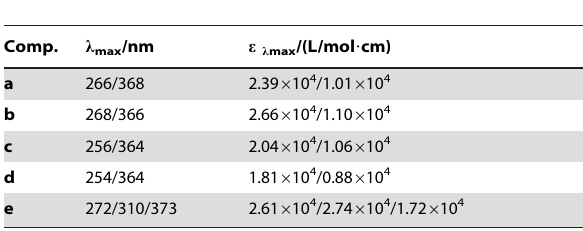
Table 6. Electronic absorption spectra of a–e in ethanol.